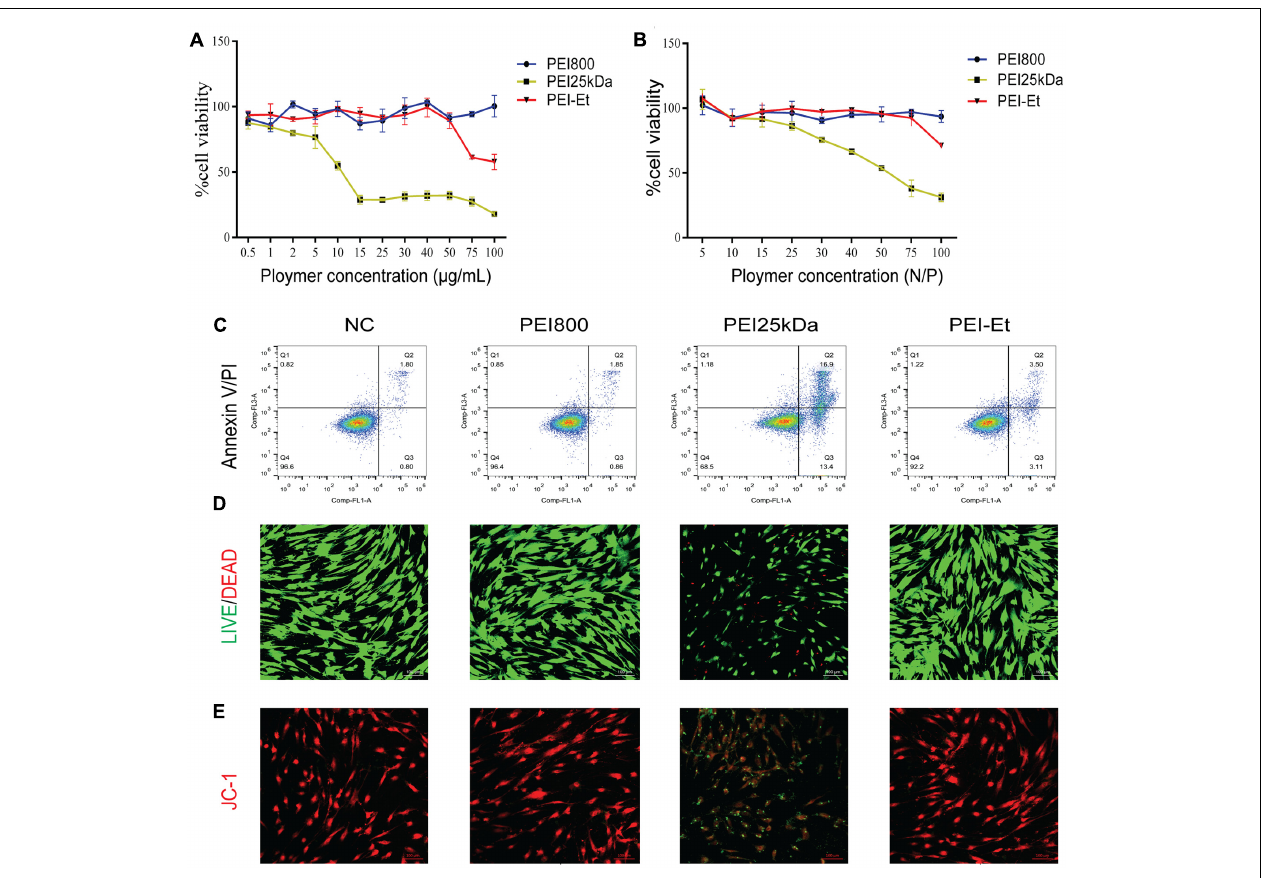
FIGURE 2 | Cytotoxicity of PEI-Et and PEI-Et/siRNA polyplexes to hBMSCs. (A) Cytotoxicity of different transfection vectors at concentrations ranging from 0.5 to 100 µ g/mL. Data represents the means ± SD of three independent experiments, N = 3. (B) Cytotoxicity of different transfection polyplexes at different N/P ratios. Data represent the means ± SD of three independent experiments, N = 3. (C) Apoptosis of hBMSCs measured with Annexin V/PI staining after transfection with different polyplexes. Q1: dead cells/cellular debris, Q2: late apoptotic/necrotic cells, Q3: early apoptotic cells, Q4: normal cells. (D) Cell viability of hBMSCs measured using the LIVE/DEAD Viability/Cytotoxicity Assay Kit after transfection with different polyplexes. Green: normal cells; Red: dead cells. The scale is 100 µ m. (E) Mitochondrial membrane potentials of hBMSCs measured using JC-1 stain. Red: normal mitochondrial membrane potential; Green: reduced mitochondrial membrane potential. The scale is 100 µ